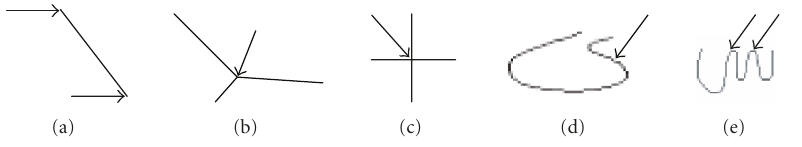
Figure 5: Some structural features: (a) end points, (b) branch point, (c) cross point, (d) inflection point, (e) cusp